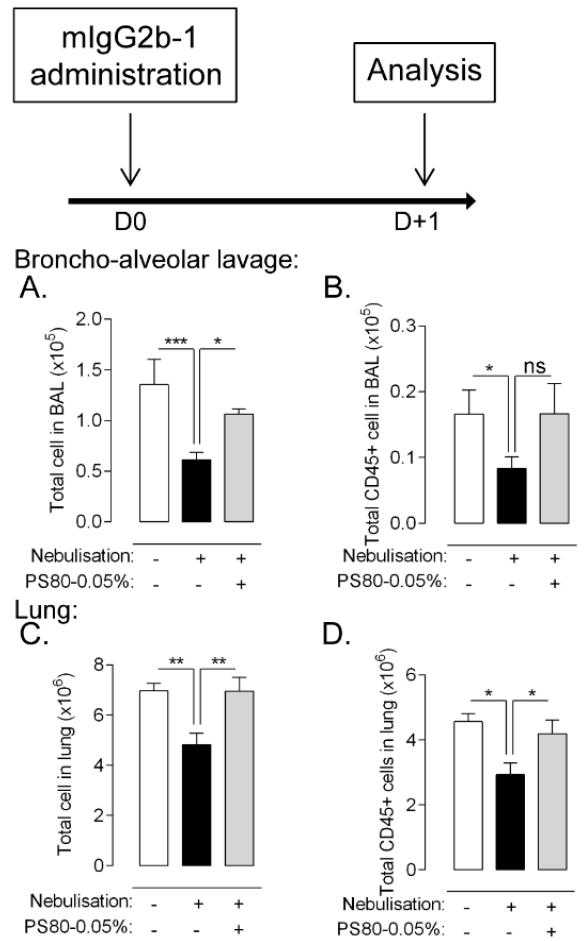
Figure 7. B6 mice received a 40 µL orotracheal instillation of mIgG2b-1 at 100 µg/mL either native (white bars), nebulized (black bars) or nebulized + 0.05%-PS80(gray bars). The total number of cells ( A , C ) and CD45+ cells ( B , D ) were quantified in BAL ( A , B ) and in the lungs ( C , D ) using flow cytometry, 18 h after the administration. The data are quoted as the mean ± SEM. *, **, ***: p < 0.05, p < 0.01 and p < 0.001, respectively, in a t-test. The results are representative of two independent experiments ( n = 5 mice/experiment).